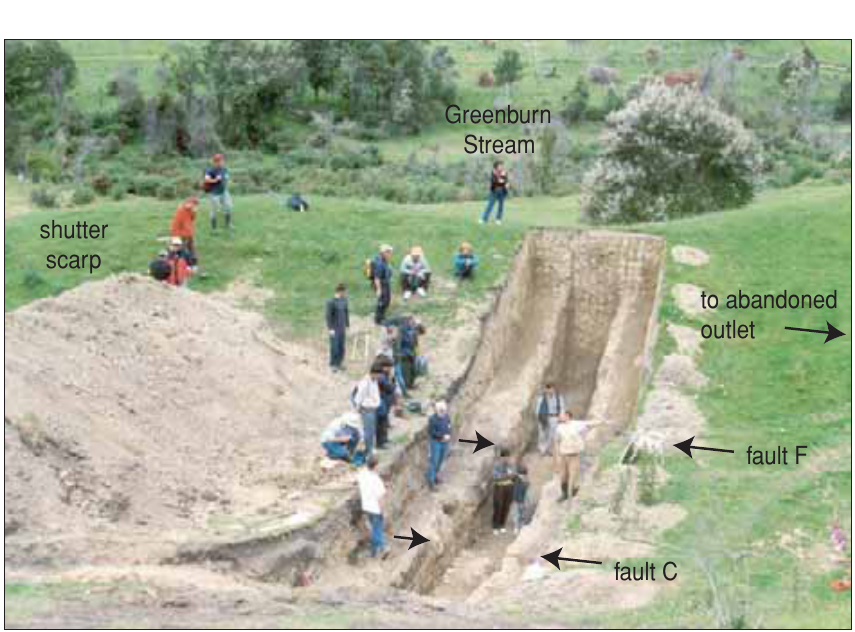
Paleoseismology and slip rate of the Conway Segment of the Hope Fault at Greenburn Stream, South Island, New